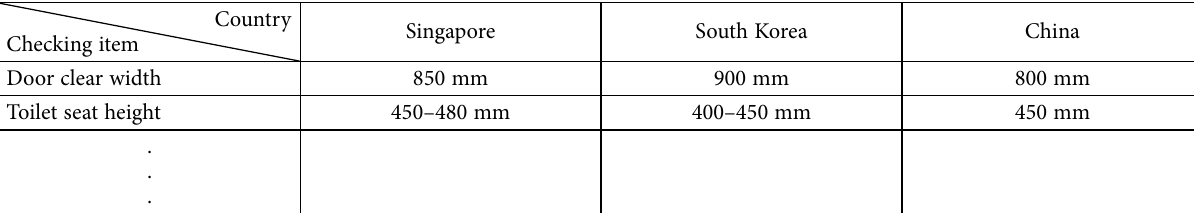
Table 1. Some checking items for accessible toilets in Singapore, South Korea, and China Country Checking